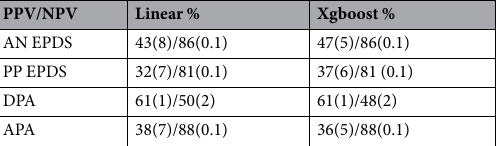
Table 9. Ten-fold cross validated positive predictive value (PPV) and negative predictive value (NPV) for prediction of depression based on predictors using linear regression (linear), and extreme gradient boosting (xgboost). In brackets the standard deviation based on 20 random iterations. AN = antenatal; PP =